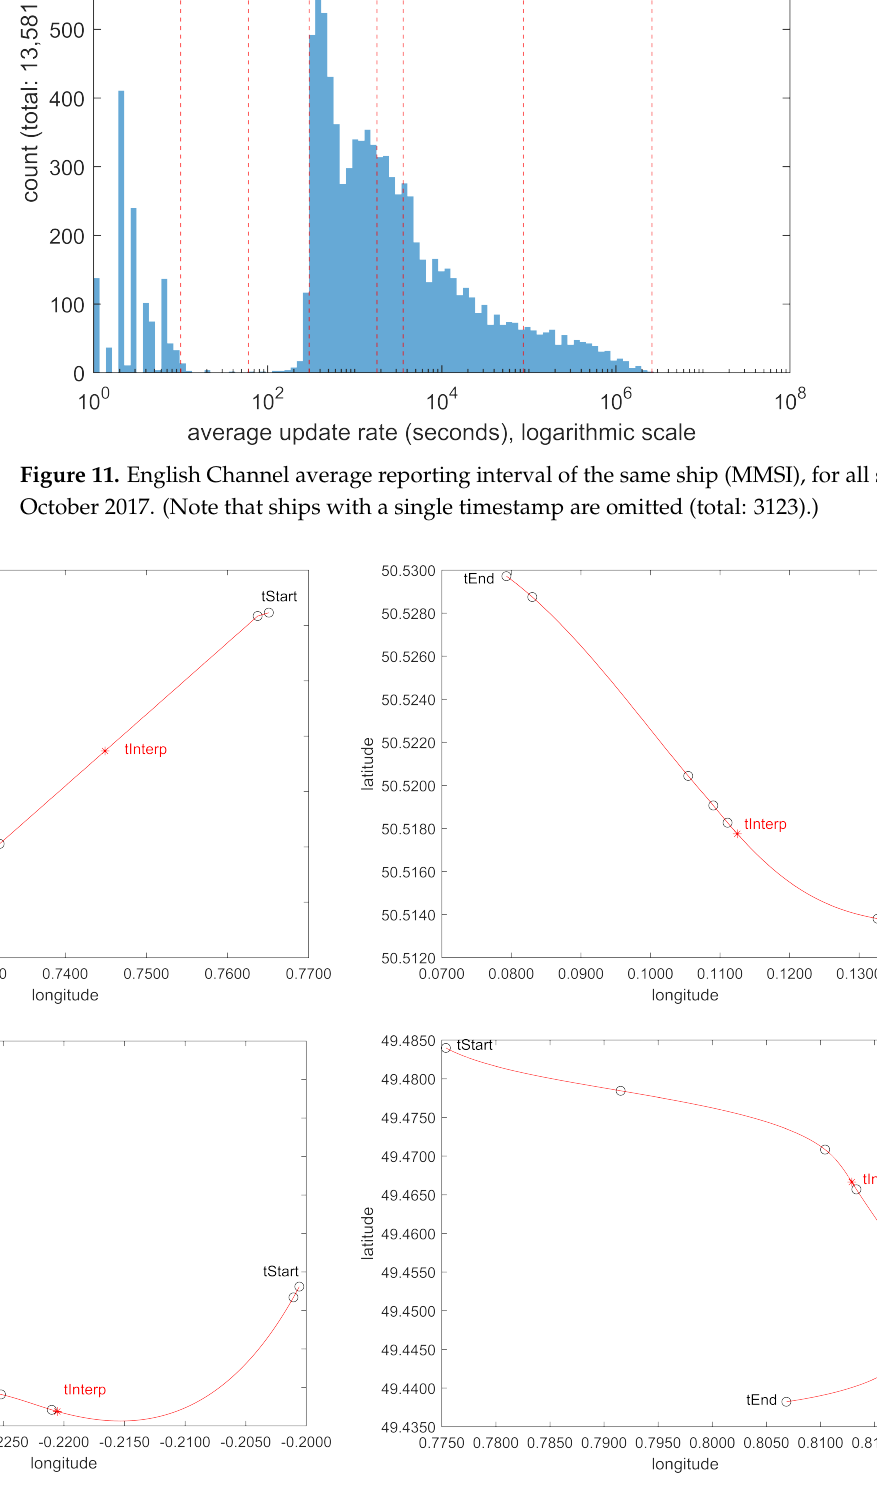
Figure 12. English Channel interpolation